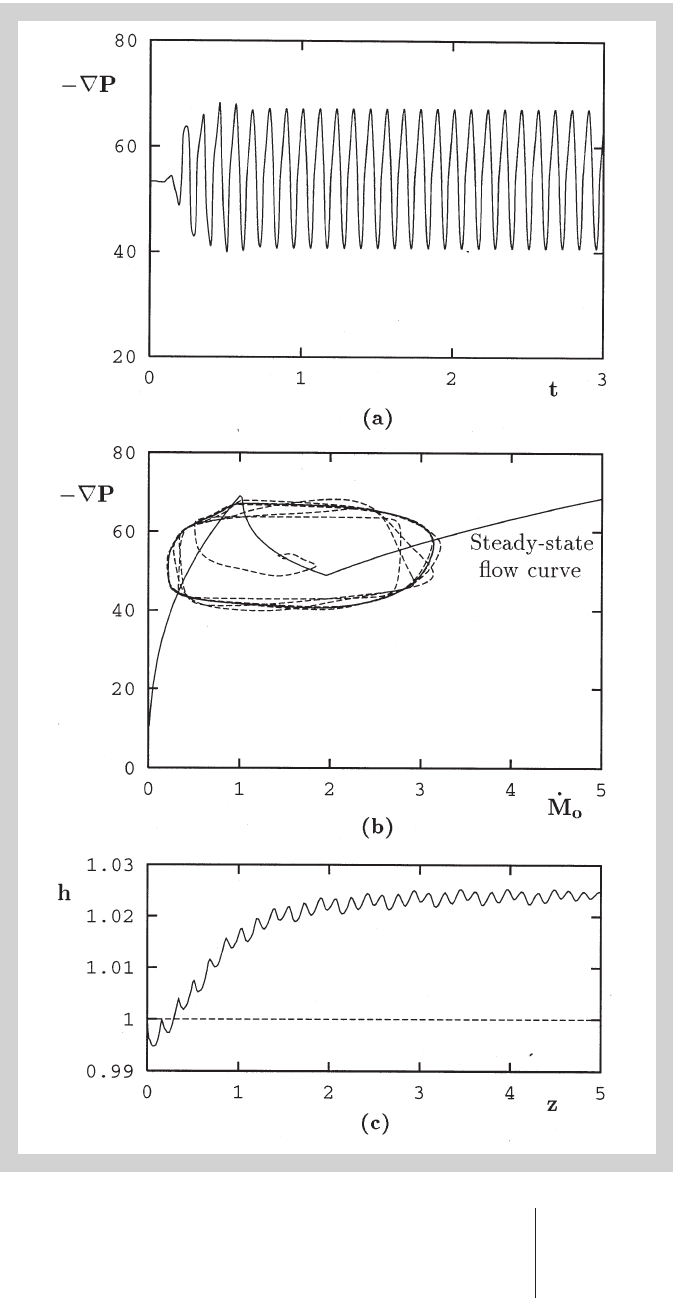
Figure 4 (right): Transient extrudate-swell flow of a Carreau fluid with n = 0.44, Re = 0.01, B = 1.541*10 -4 and Q =1.5: (a) Evolution of the pressure drop; (b) Trajectory of the solution on the flow curve plane; (c) Oscillations of the free